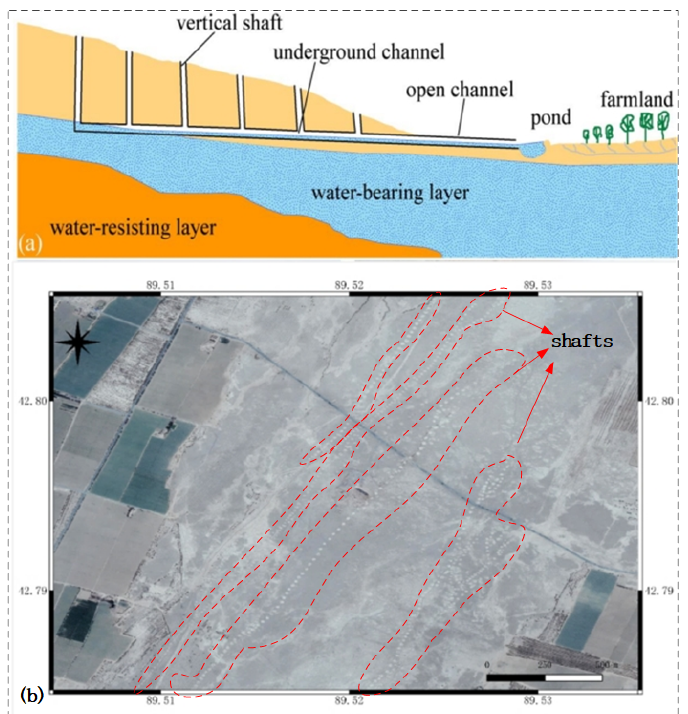
Figure 1. ( a ) Cross-sectional view and ( b ) top view (satellite image) of a karez structure, the red dotted line in the figure indicates the location of the shaft. It can be seen from the cross-section that a karez is an underground culvert composed of vertical wells of different depths, with the parent well being connected to the underground aquifer. In the top view, the line formed by the shaft wellheads marks the course of the